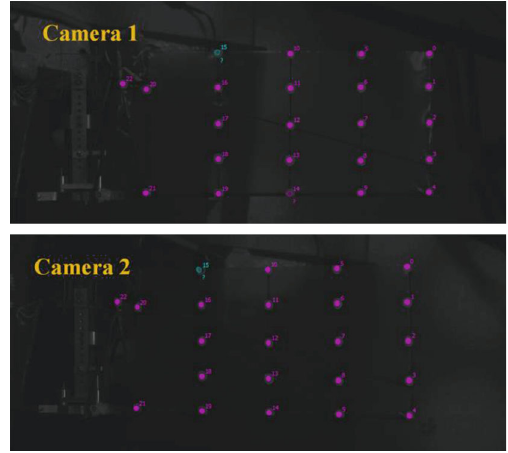
Figure 8: Completed speckle recognition.